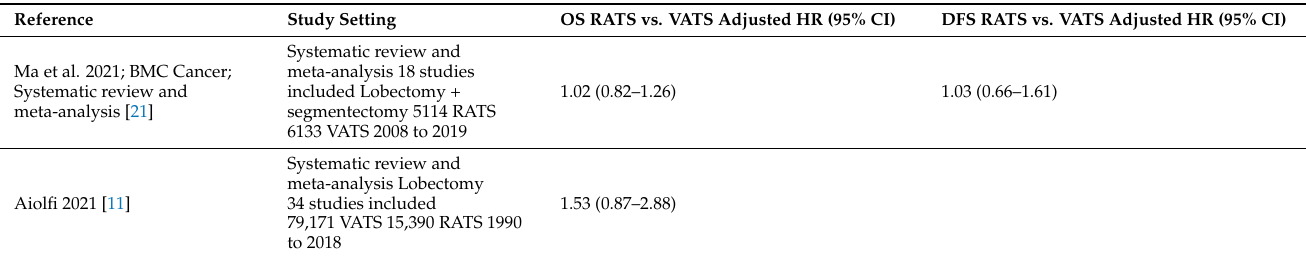
Table 6. Main results of systematic review and meta-analysis, and matched cohort analysis